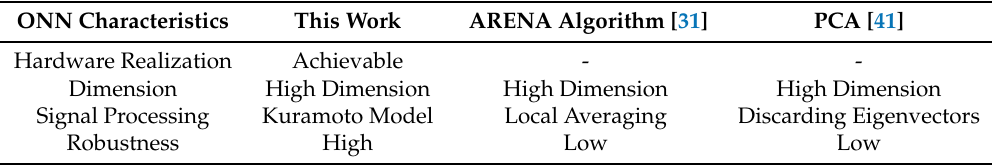
Table 3. Comparison of the proposed work with other algorithms.